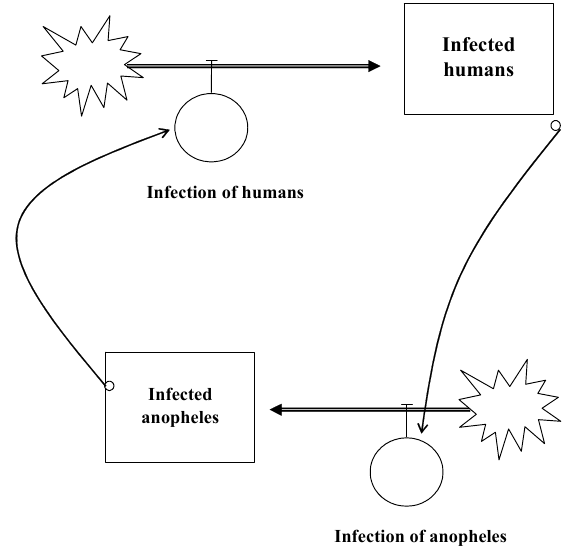
Figure 7. Causal Loop Diagram of Malaria. Source own, based on [24].